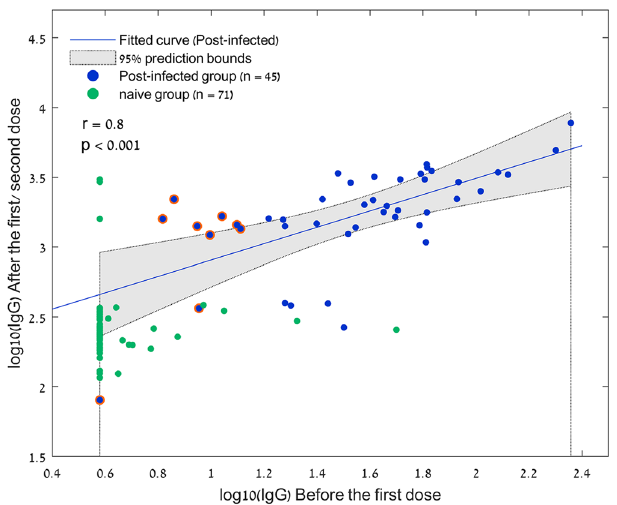
Figure 4. Scatterplot of the IgG-S responses before vaccination, and the corresponding responses after the first dose in the post-infected cohort (blue), and before vaccination and after the second does in the naive cohort (green). r is Pearson’s correlation coefficient. The 95% prediction interval is presented in the gray area. Post- infected participants who were found seronegative prior to their vaccination are highlighted in